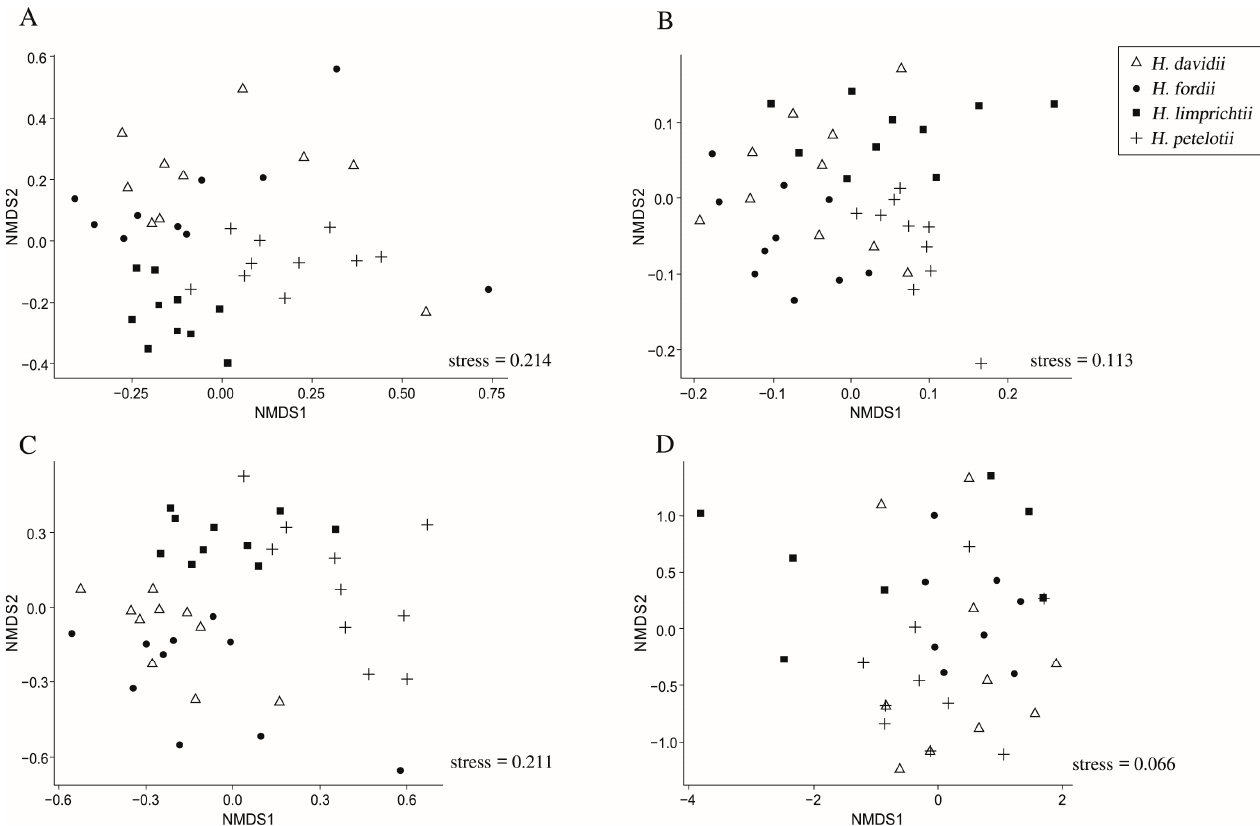
Figure 3. Non-metric multidimensional scaling (NMDS) plots based on all endophytic fungal OTUs and OMF OTUs obtained from the four studied Habenaria root samples using primer combinations ITS3/ITS4OF or ITS86F/ITS4 and clustered at 3% sequence dissimilarity. ( A ) All endophytic fungal OTUs obtained from ITS3/ITS4OF. ( B ) OMF OTUs obtained from ITS3/ITS4OF. ( C ) All endophytic fungal OTUs obtained from ITS86F/ITS4. ( D ) OMF OTUs obtained from ITS86F/ITS4. 2.5. Network Structure of Plant-Endophytic Fungi with Primer ITSITS86F/ITS4 and Primer